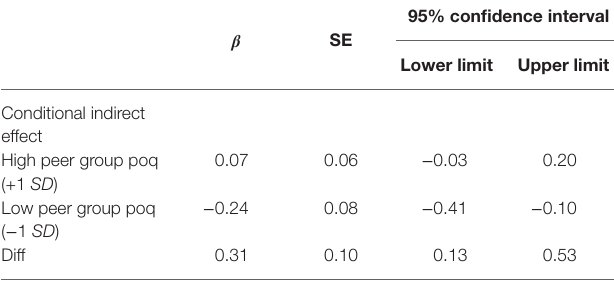
TABLE 4 | Results of moderated mediation effect.